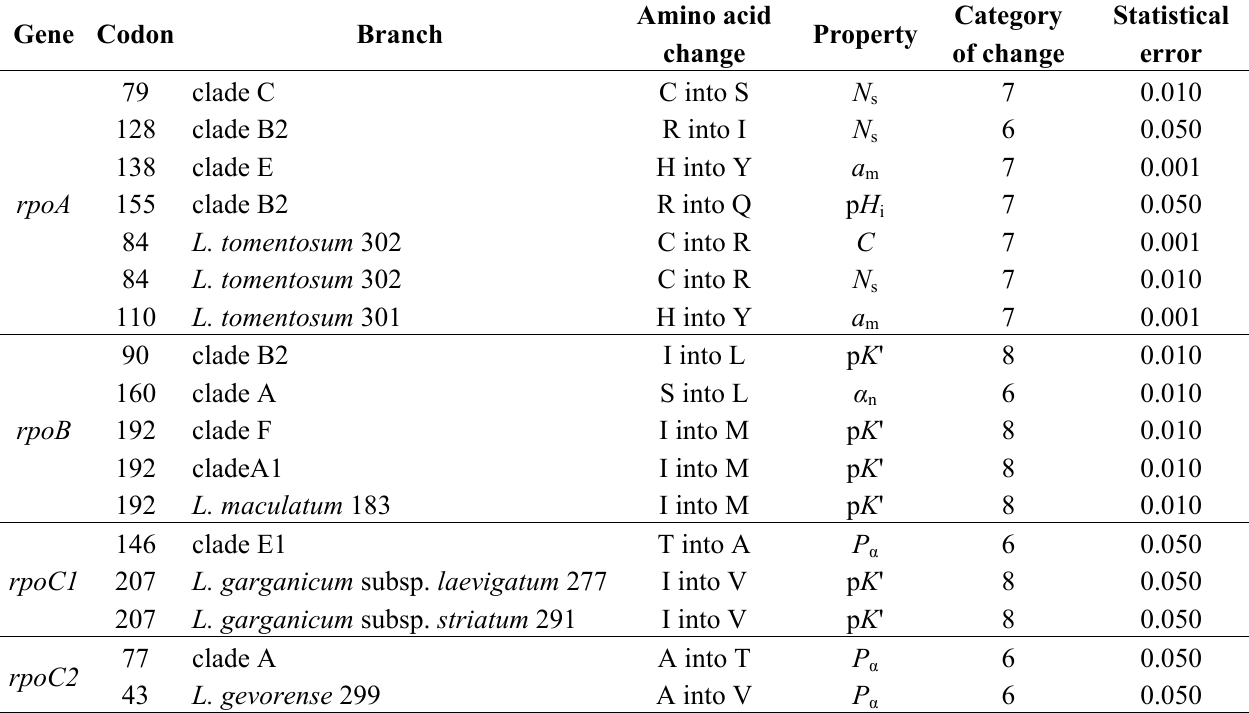
Table 2. Characteristics of radical amino acid property changes under positive destabilizing selection in rpo genes (an outgroup not